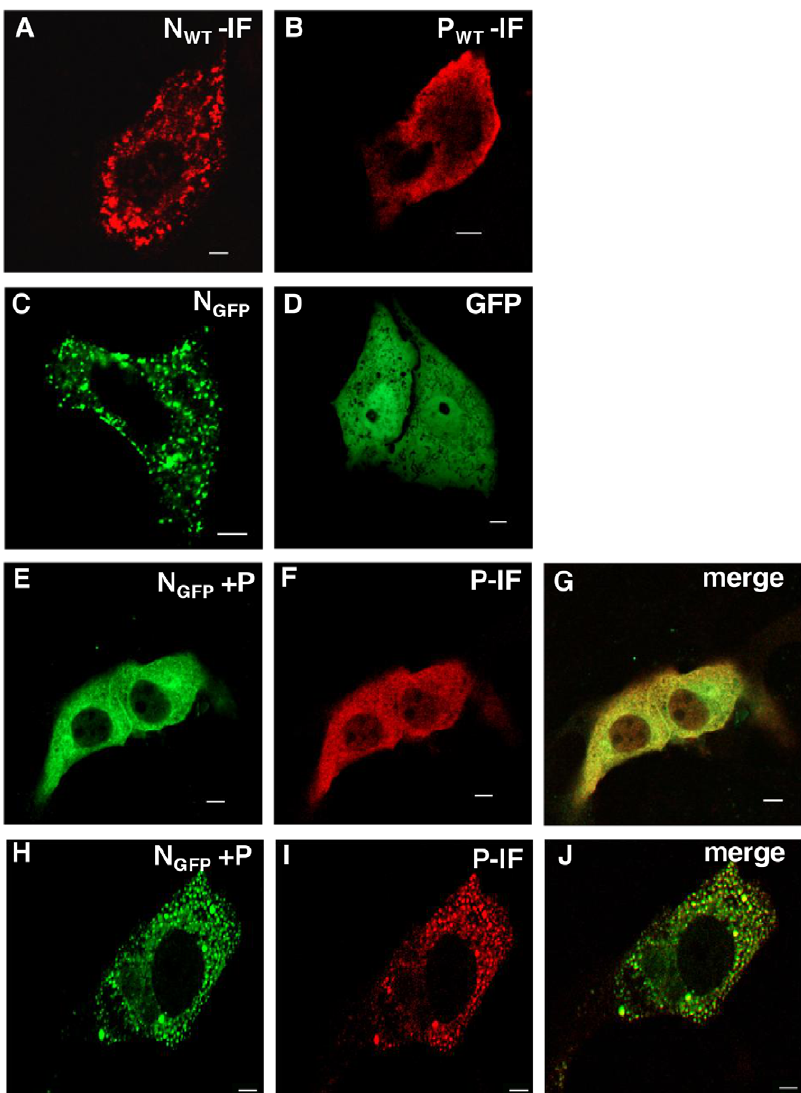
Figure 1. CHPV N and P proteins interact differentially in transfected cells depending on their stoichiometric availabilities. (A) Vero- 76 cells were transfected with 2 m g pCDNA 3.1 ( + ) N and immunofluorescence performed with N-Ab, 24 hours post transfection. N exhibits a punctate distribution in the cytoplasm. (B) Immunofluorescence of Vero-76 cells transfected with pCDNA 3.1 ( + ) P, with P-Ab. P exhibits a smooth distribution in the cytoplasm. (C) GFP fluorescence of Vero-76 cells transfected with pEGFP-C1 N. GFP-tagged N maintains its punctuated distribution. (D) GFP fluorescence of Vero-76 cells transfected with pEGFP-C1 vector alone. GFP alone shows characteristic smooth fluorescence throughout the cell. (E to G) Vero-76 cells co-transfected with pEGFP-C1 N and pCDNA 3.1 ( + ) P in a 1:1 ratio. P was detected by immunofluorescence (F). Colocalization of GFP-N with P is shown in the merged image (G). Co-expression with P redistributes the otherwise punctuated N into a more homogenous fluorescence. (H to J) Co-transfection in a 1:0.5 ratio. The lower abundance of P is insufficient to homogenise the punctuated distribution of N (H). Immunofluorescence against P reveals colocalization of P with oligomeric forms of N (I and J). All data were captured on a laser scanning confocal microscope (Carl Zeiss). All Immunofluorescence were performed with anti-rabbit TRITC conjugated secondary antibody. 2 m g of DNA was used for all transfection, except for H, I and J where 1 m g of pCDNA 3.1 ( + ) P was used. The bar represents 5 m m.